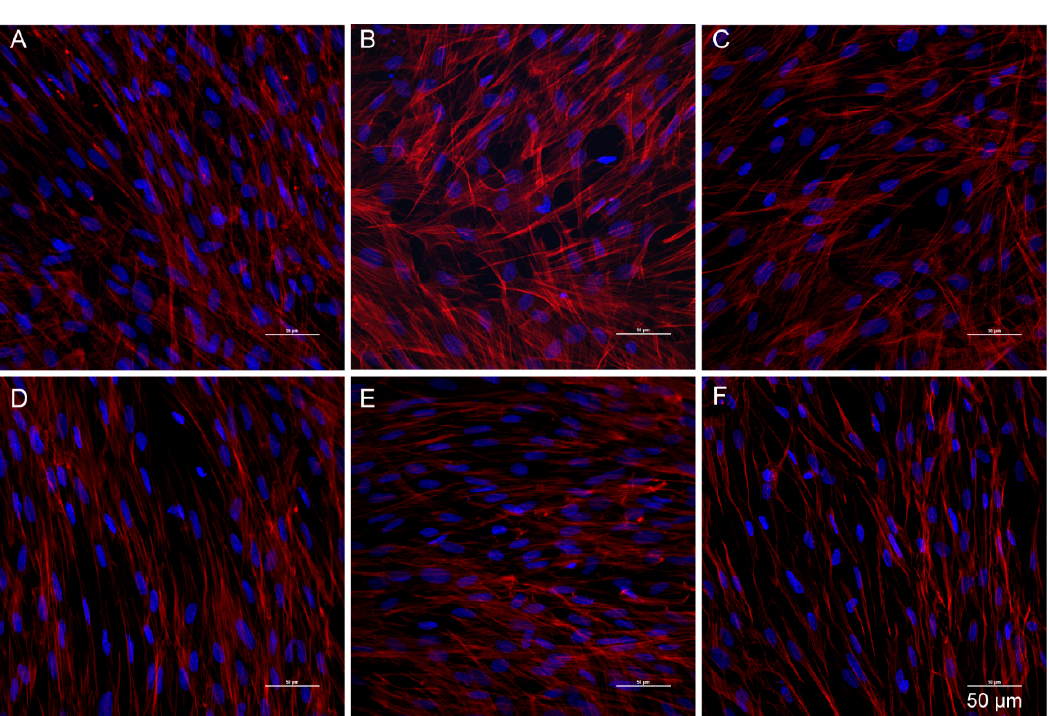
Figure 7. The effects of catalpol on ZO-1 decreased expression induced by LPS detected by immunofluorescence staining. ( A ) normal group; ( B ) model group; ( C ) Fasudil group; ( D ) catalpol 0.3 μ M group; ( E ) catalpol 3.0 μ M group; ( F ) catalpol 30.0 μ M group.